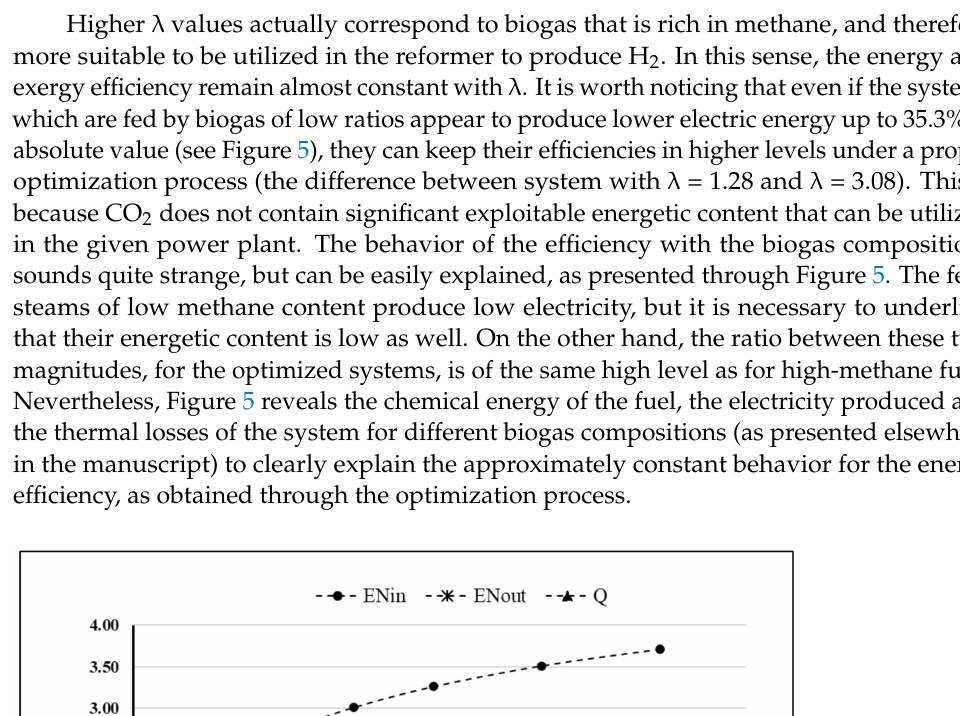
Figure 4. Effect of “ λ ” on system’s efficiency.